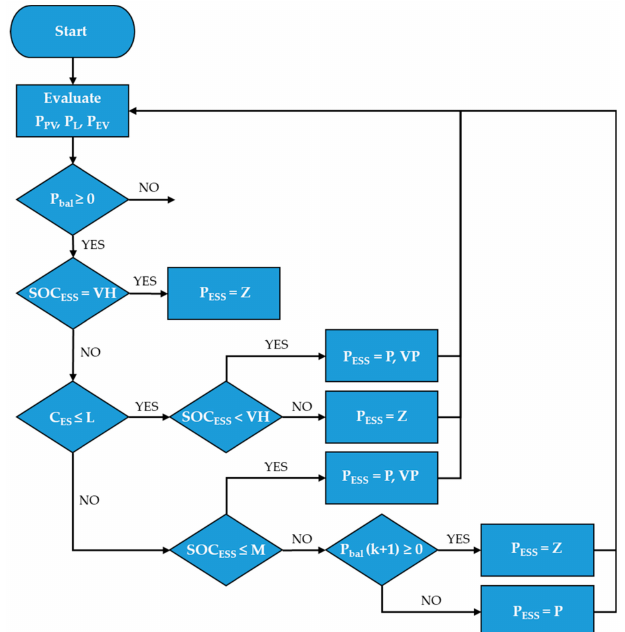
Figure 7. FLC1 flowchart diagram in the sampling k when there is an energy surplus situation (VL: Very Low, L: Low, M: Medium, Z: Zero; P: Positive, VP: Very Positive, VH: Very High; according to membership functions defined in Figure 5). It is understood that the sets used are